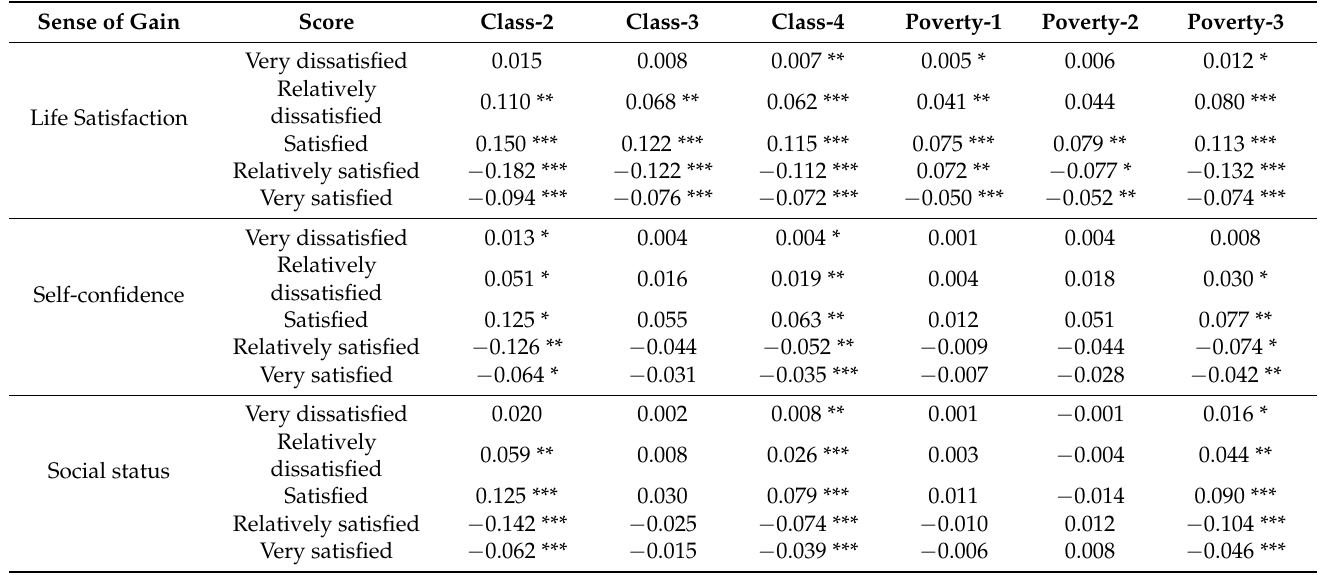
Table 8. Analysis of the marginal effect of subjective perception of